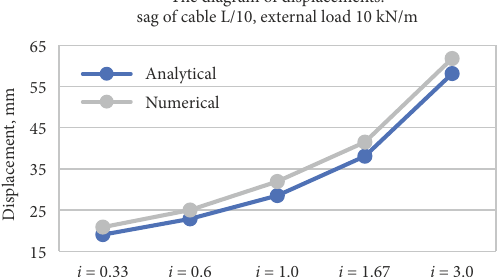
Figure 5. The diagram of displacements, in case the load is transferred to the columns, the string is not pre-tensioned diagram of shear forces: sag of cable L/10, external load 10